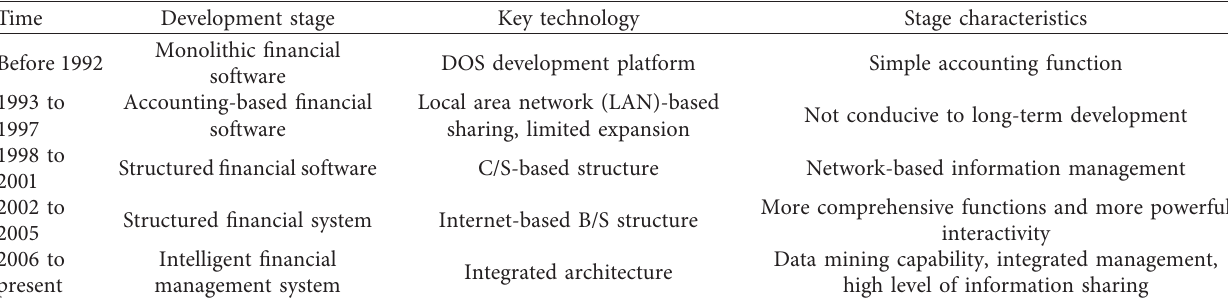
Table 1: Enterprise economic management system development